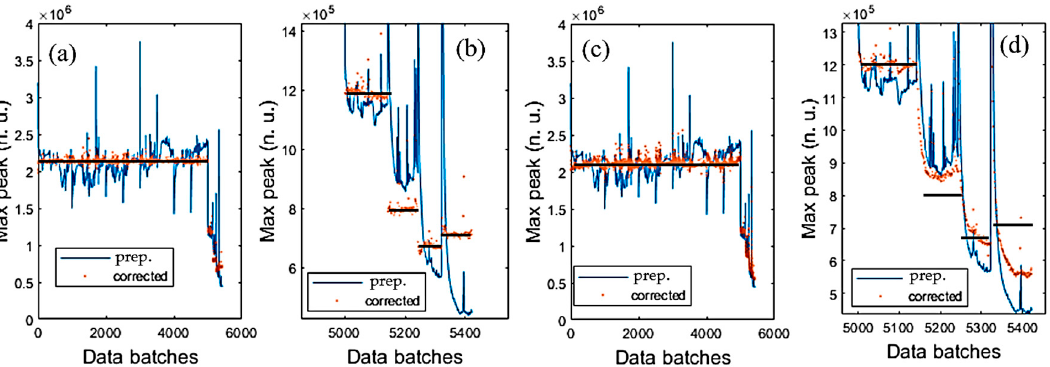
Figure 9. The ACKF preprocessed (prep.) and corrected max peak (MP) data of λ 1 thermopile of using entropy and absolute-mean error function (AME) criteria respectively. ( a ) Full view of the data achieved by entropy criterion; ( b ) close view of the data batches from 5001 to 5422 achieved by entropy criterion; ( c ) full view of the data achieved by AME and ( d ) close view of the MP data from the batches of 5001 to 5422 achieved by AME criterion.